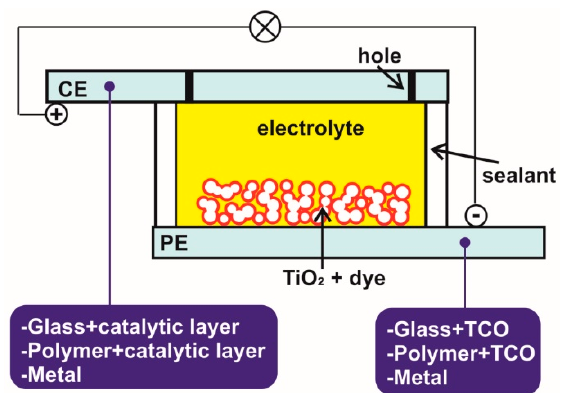
Figure 3. Schematic illustration of the different possible configurations of dye-sensitized solar cells (DSSCs) (DSSCs) [29,30].